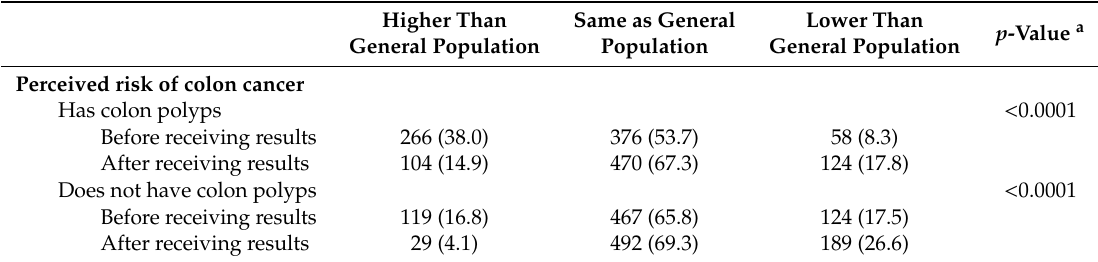
Table 2. Perceived risk of colon cancer and heart disease for participant with and without respective phenotypes before and after receiving results as compared to the general